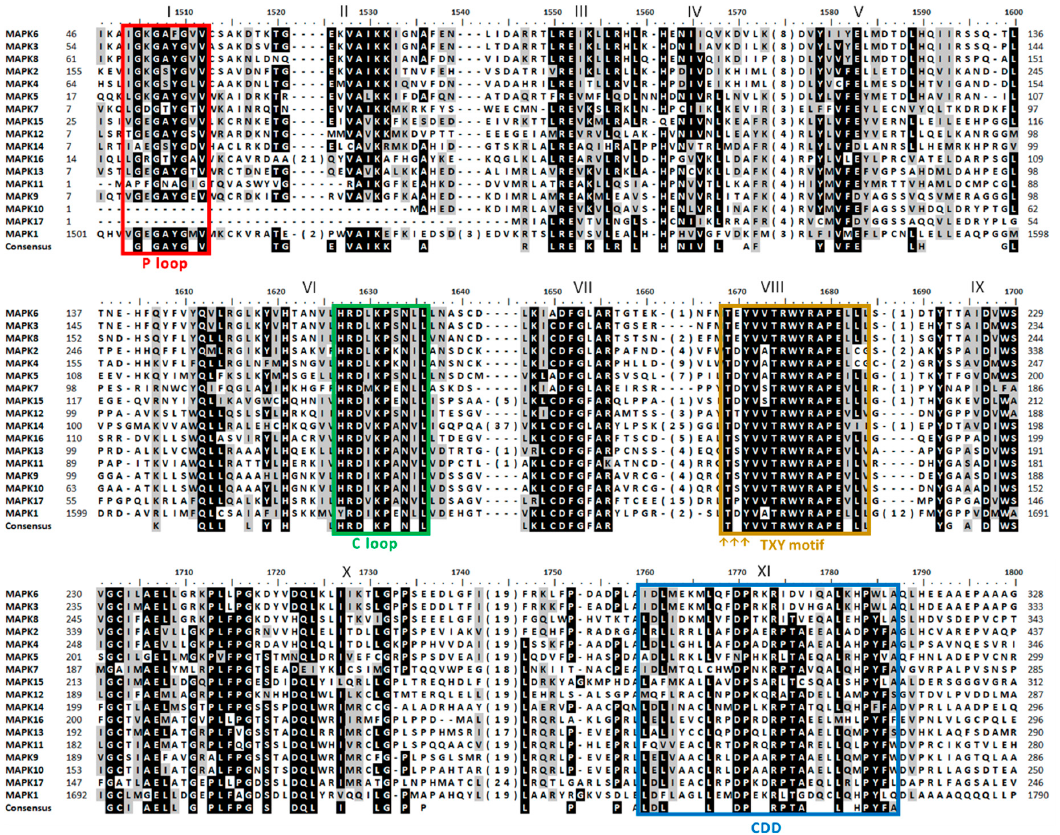
Figure 1. Sequence alignment of MAPK family. A simplified alignment (ClustalW) of the 17 MAPKs identified along with the consensus sequence is shown. The 11 MAPK domains are shown in roman numerals (I-XI). The TxY motif is highlighted with three arrows ( ↑ ) in the activation domain. Highly conserved amino acids are shown on a black background, and moderately conserved amino acids are shown on a gray background. The numbers in brackets in the alignment represent the lengths of poorly conserved inserts that have not been shown to maximize the alignment. The P, C and T loops and the CDD are highlighted in colored rectangles.